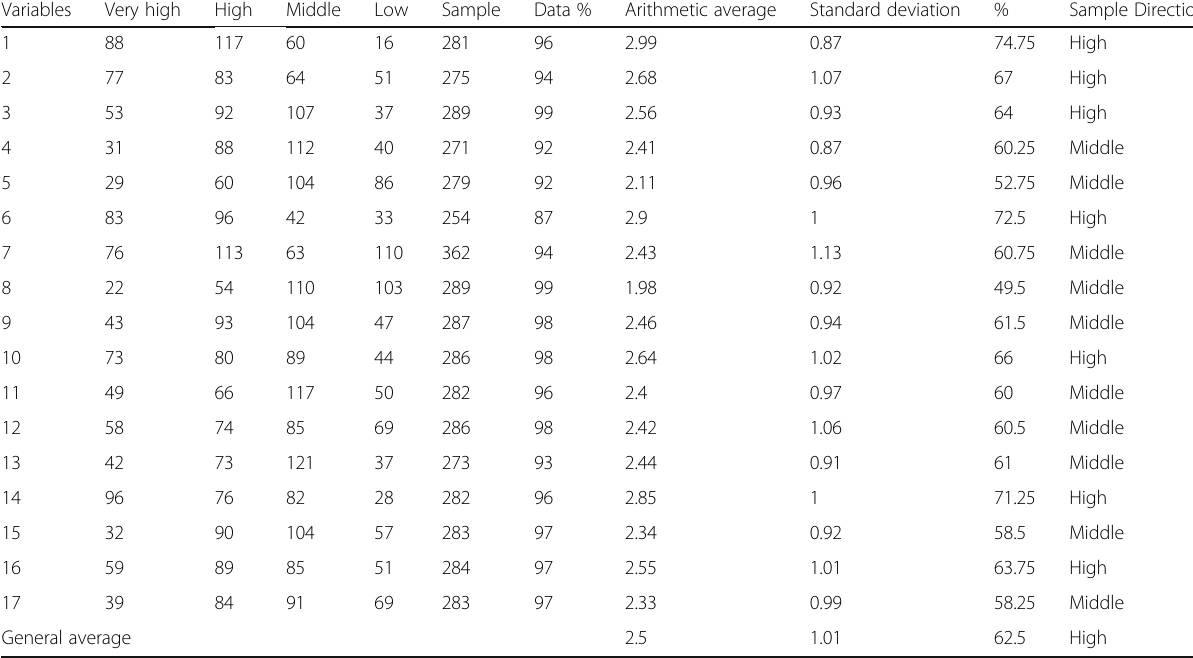
Table 2 Summary of the responses on drought common variables in Draa Valley